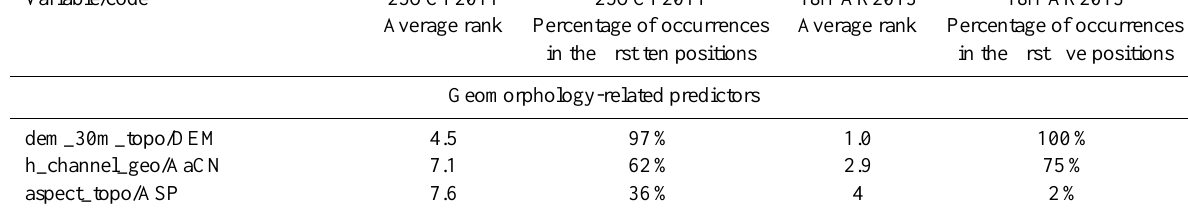
Table 6. List of predictors classified as “important” by the RF algorithm for 25OCT2011 and 18MAR2013. The average position and the percentage of occurrences in the first 10 (5) positions in 25OCT2011 (18MAR2013) ranking are computed over the 100 runs of